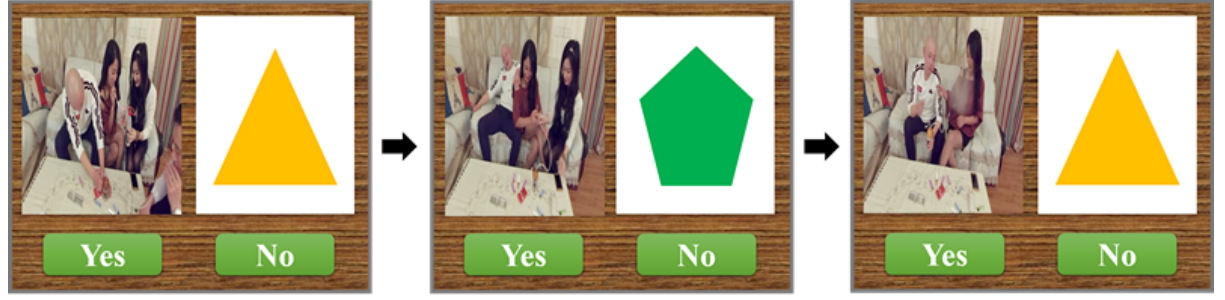
Figure 3. Methamphetamine-related working memory training task (N-back task). The previous Figure 2 is an example of 2-back task training. Patients in the CCAT group were asked to decide the whether the figure (both shape and color) on the right was consistent with the figure showing the previous two pictures while ignoring the methamphetamine-related picture on the